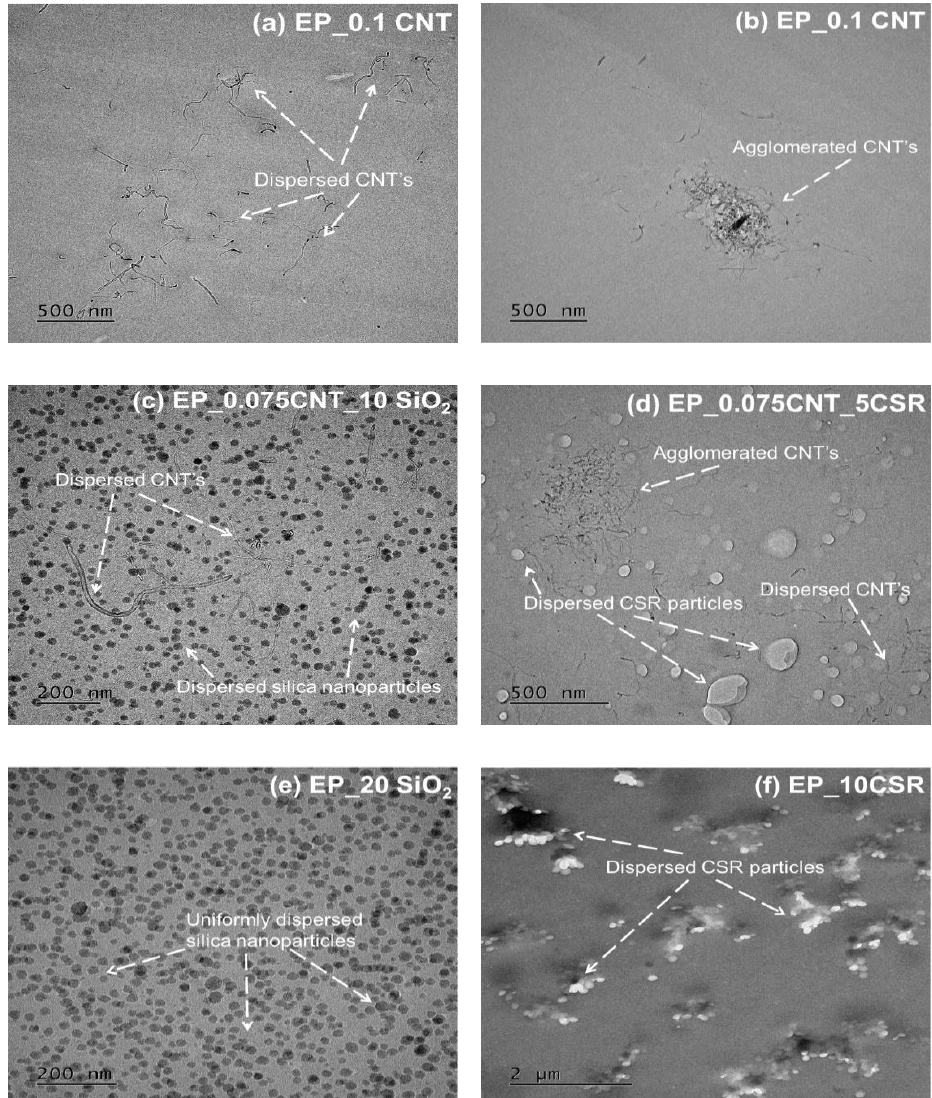
Figure 2. TEM images showing the dispersion of different fillers in modified epoxy systems. ( a )